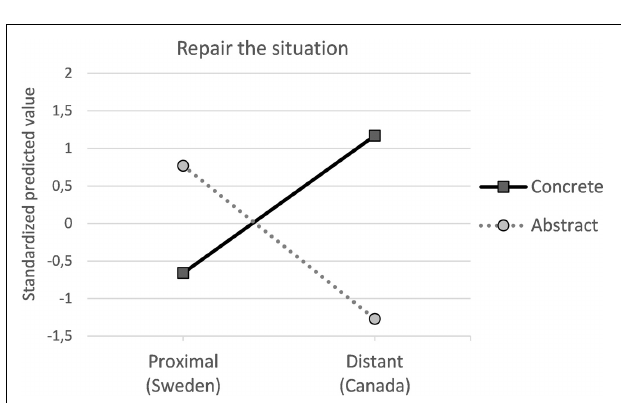
FIGURE 4 | Standardized predicted mean values for willingness to